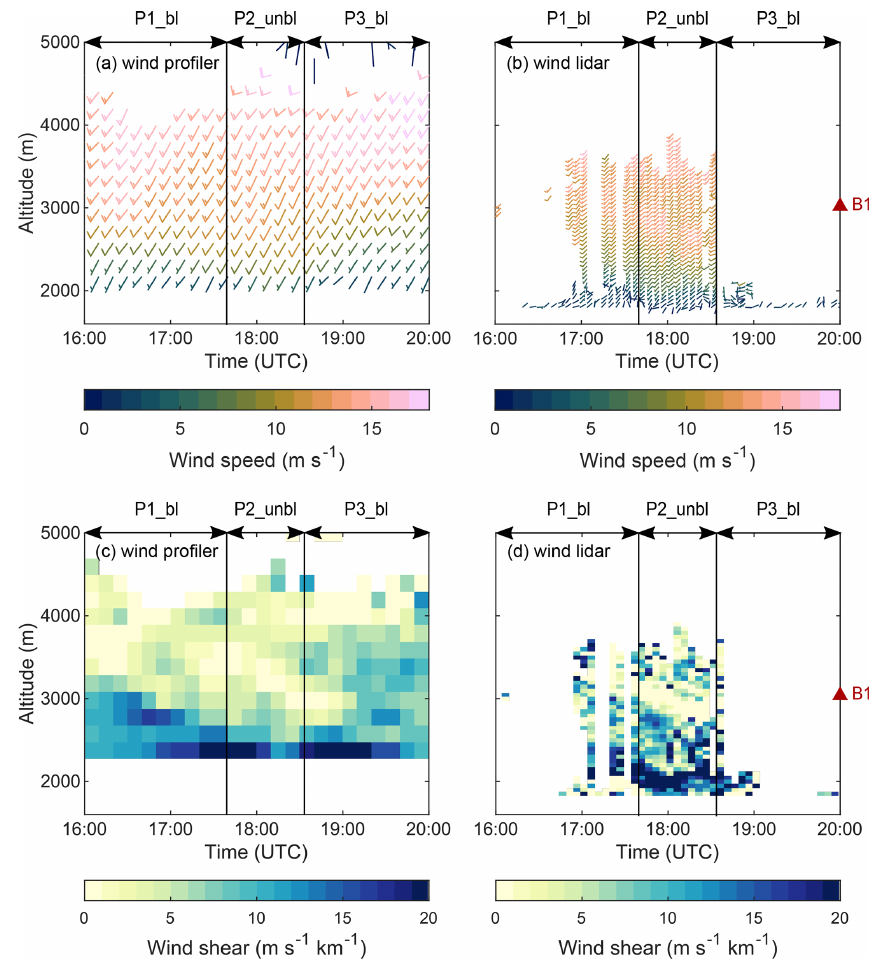
Figure 5. Vertical profiles of the horizonal wind speed and direction (a, b) and vertical shear in the horizontal wind (c, d) measured by the radar wind profiler (a, c) and wind lidar (b, d) . The vertical wind shear was calculated from the wind observations, considering changes in the horizontal wind speed between two adjacent height levels. The red triangle symbol on the right side indicates the mean height of the upstream mountain barrier B1 (see Fig.